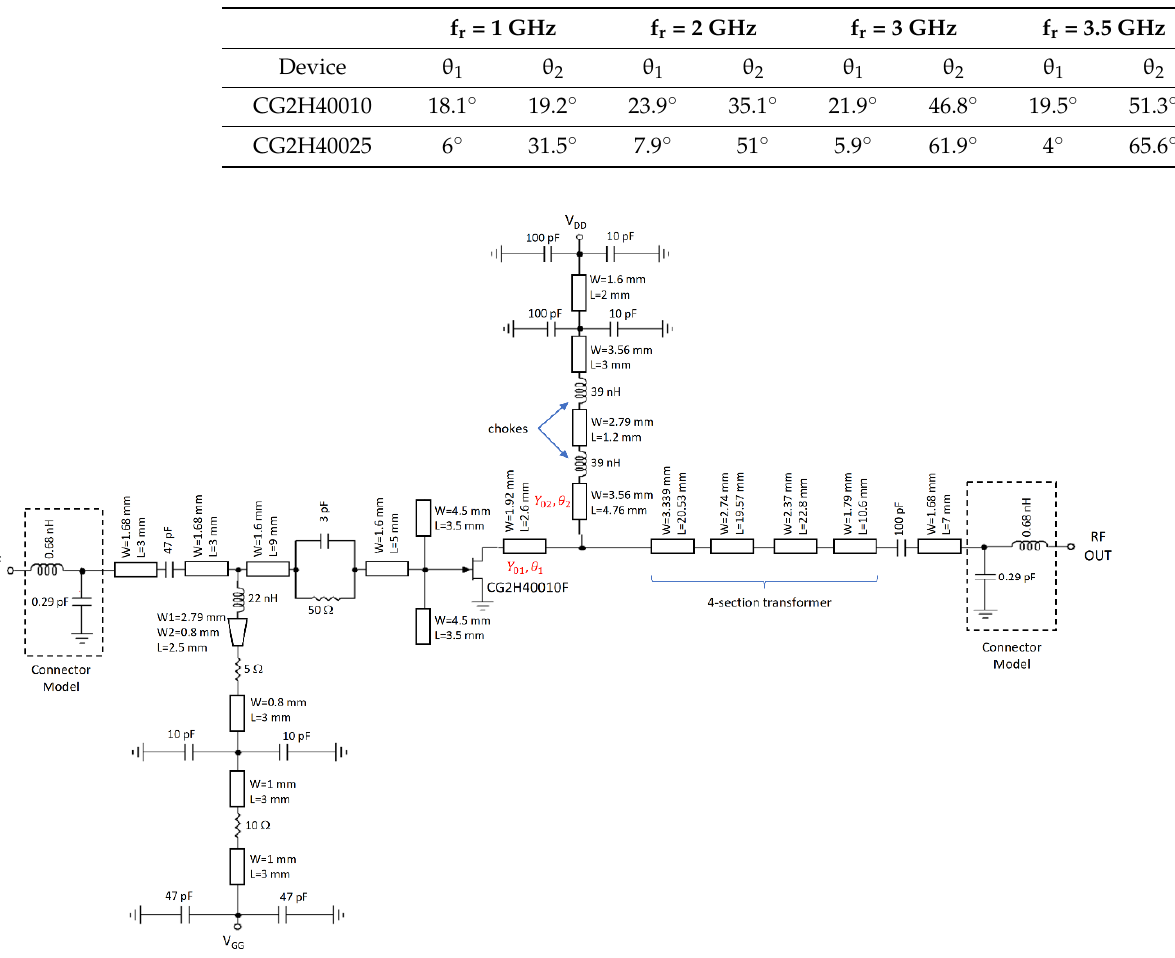
Figure 3. |Γ (cid:2919)(cid:2924)(cid:2930) | for different values of f (cid:2928) , a) using CG2H40010 and b) CG2H40025. Figure 3. | Γ int | for different values of f r , ( a ) using CG2H40010 and ( b ) CG2H40025. Table 4. θ (cid:2870) calculations for CG2H40010 and CG2H40025 for different values of f (cid:2928) . Table 4. θ 2 calculations for CG2H40010 and CG2H40025 for different values of f r .